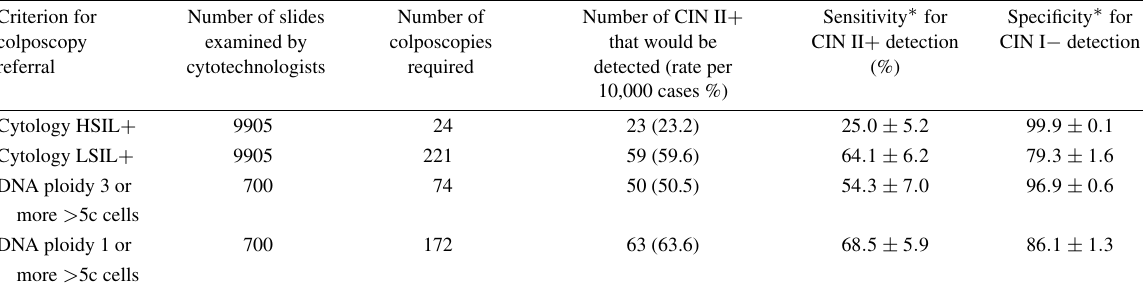
Comparative detection yields of manual cytology versus DNA assisted cytology for various colposcopy referral